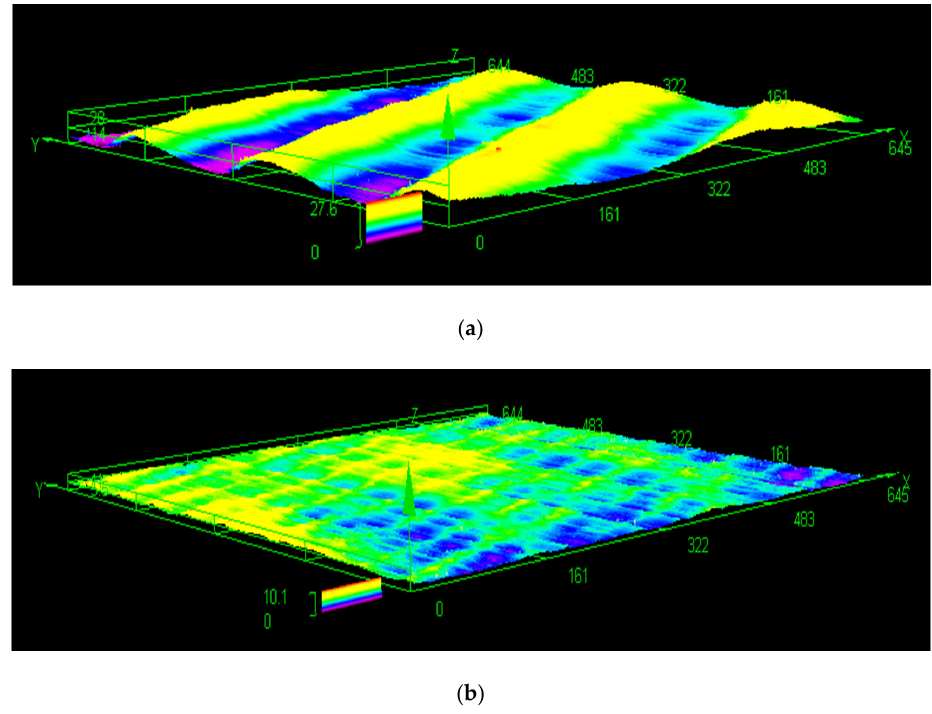
Figure 8. Surface integrity of a ( a ) 137.16 mm/min and 0.0254 mm/tooth experiment and a ( b ) 76.2 mm/min and 0.02032 mm/tooth experiment.